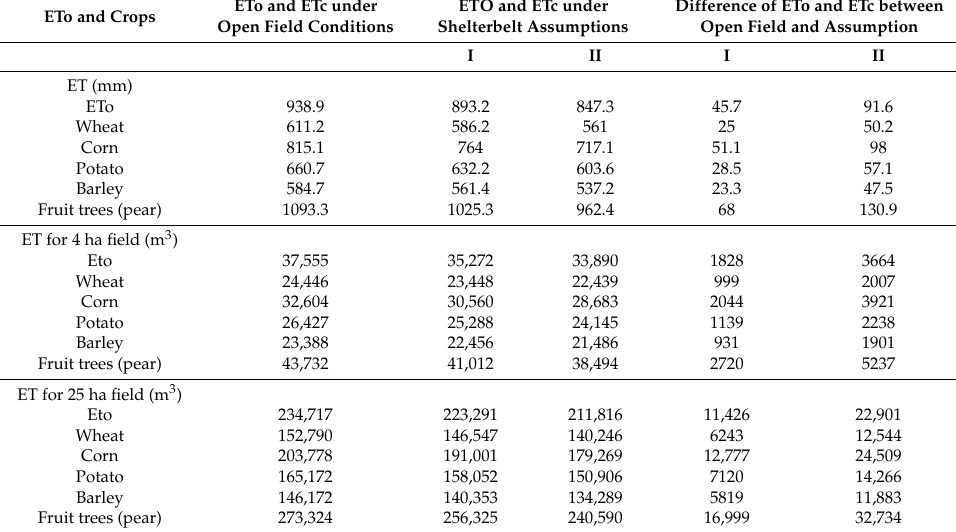
Table 4. ETo and ETc of relevant crops under open field conditions and two scenarios on impact of shelterbelts on micro climate for one growing season each. First scenario: leeward of shelterbelt wind speed is reduced by 20% compared to open field conditions. Second scenario: leeward of shelterbelt wind speed is reduced by 35%, maximum temperature is decreased by 1 °C, and minimum air humidity is increased by 0.05 compared to open field conditions.